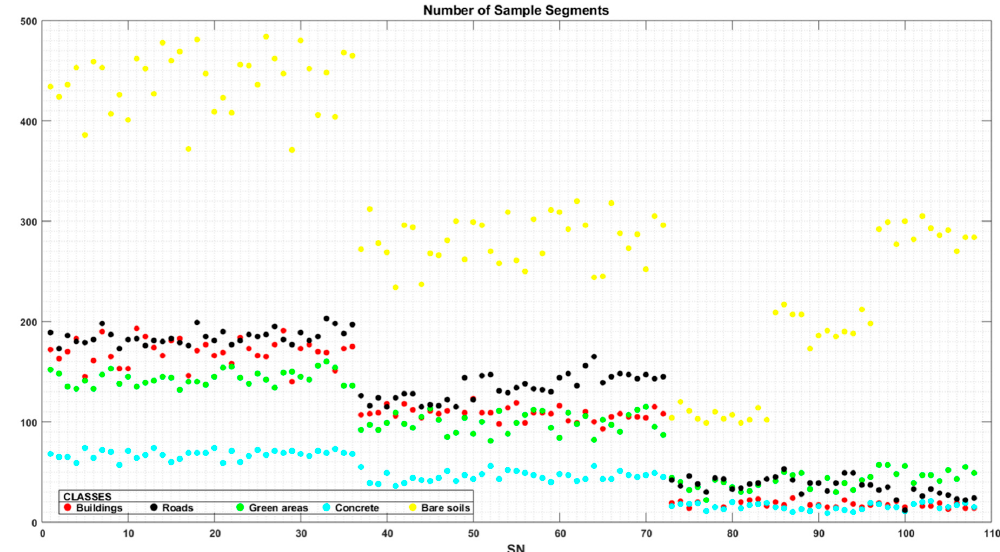
Figure 9. Number of sample-segments for each class in classifications based on SSM 3.